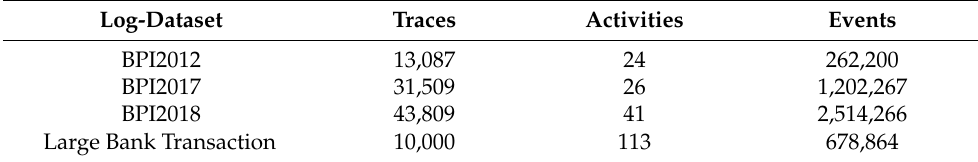
Table 1. The log-datasets used in the experimental analyses.